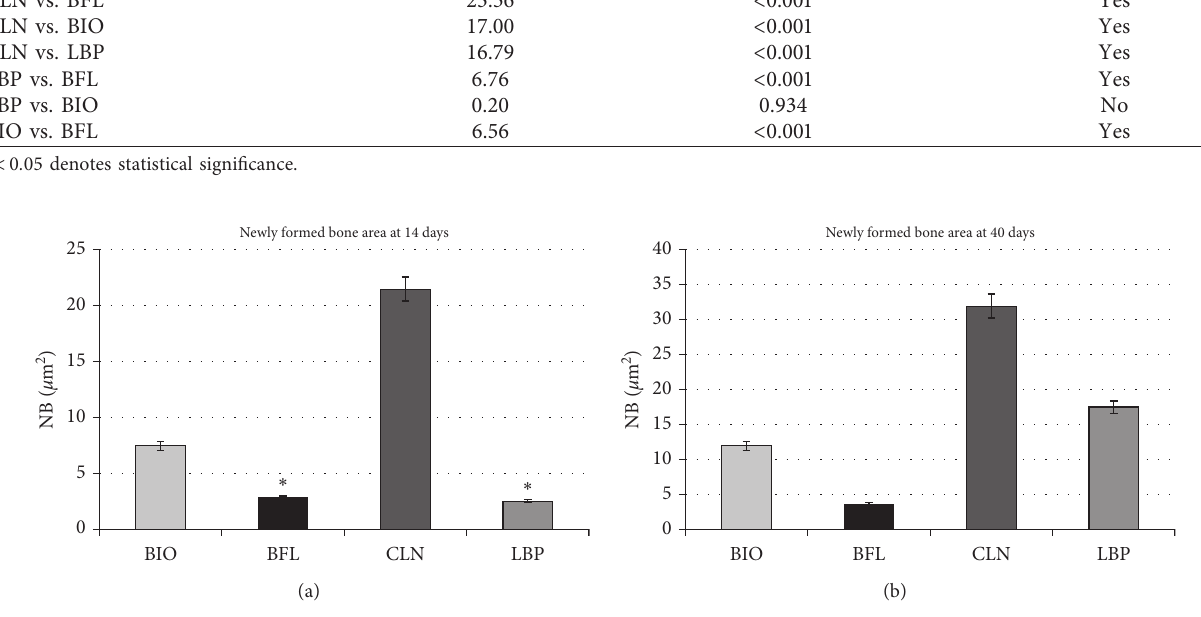
Table 2: Interactions among the biomaterials groups (Tukey test), independent of time. Biomaterials (interactions)